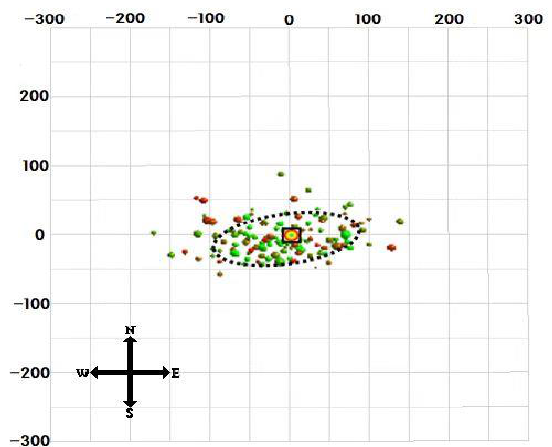
Figure 1. Downhole microseismic interpretation results.